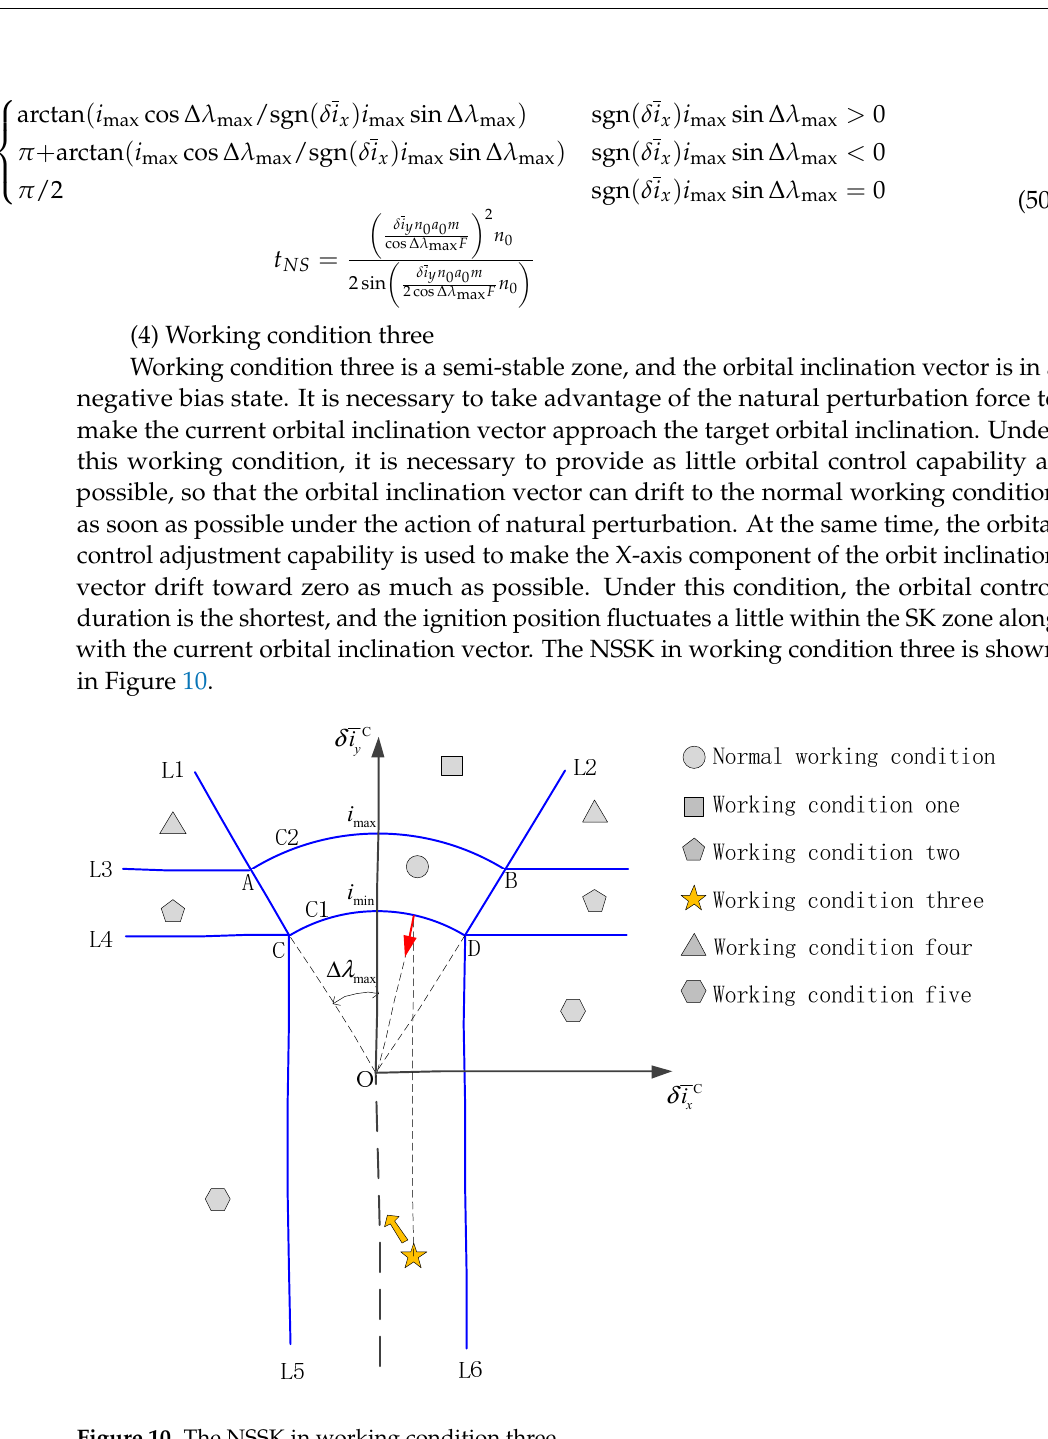
(51) (5) Working condition four Working condition four is an unstable zone, and the absolute value of the mean or- bital inclination vector in the X-axis and Y-axis directions of the inertial system is large, and it is positive in the Y-direction. In this case, it is necessary to have the orbital control capability on both the X and Y axes, the position of orbital control is at the boundary of the allowable orbital control range, and the orbital control time is the longest. The NSSK in working condition four is shown in Figure 11.